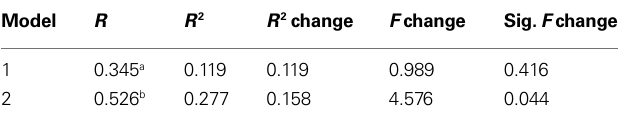
Table 4 | Multiple regression analysis for splenium of corpus callosum +